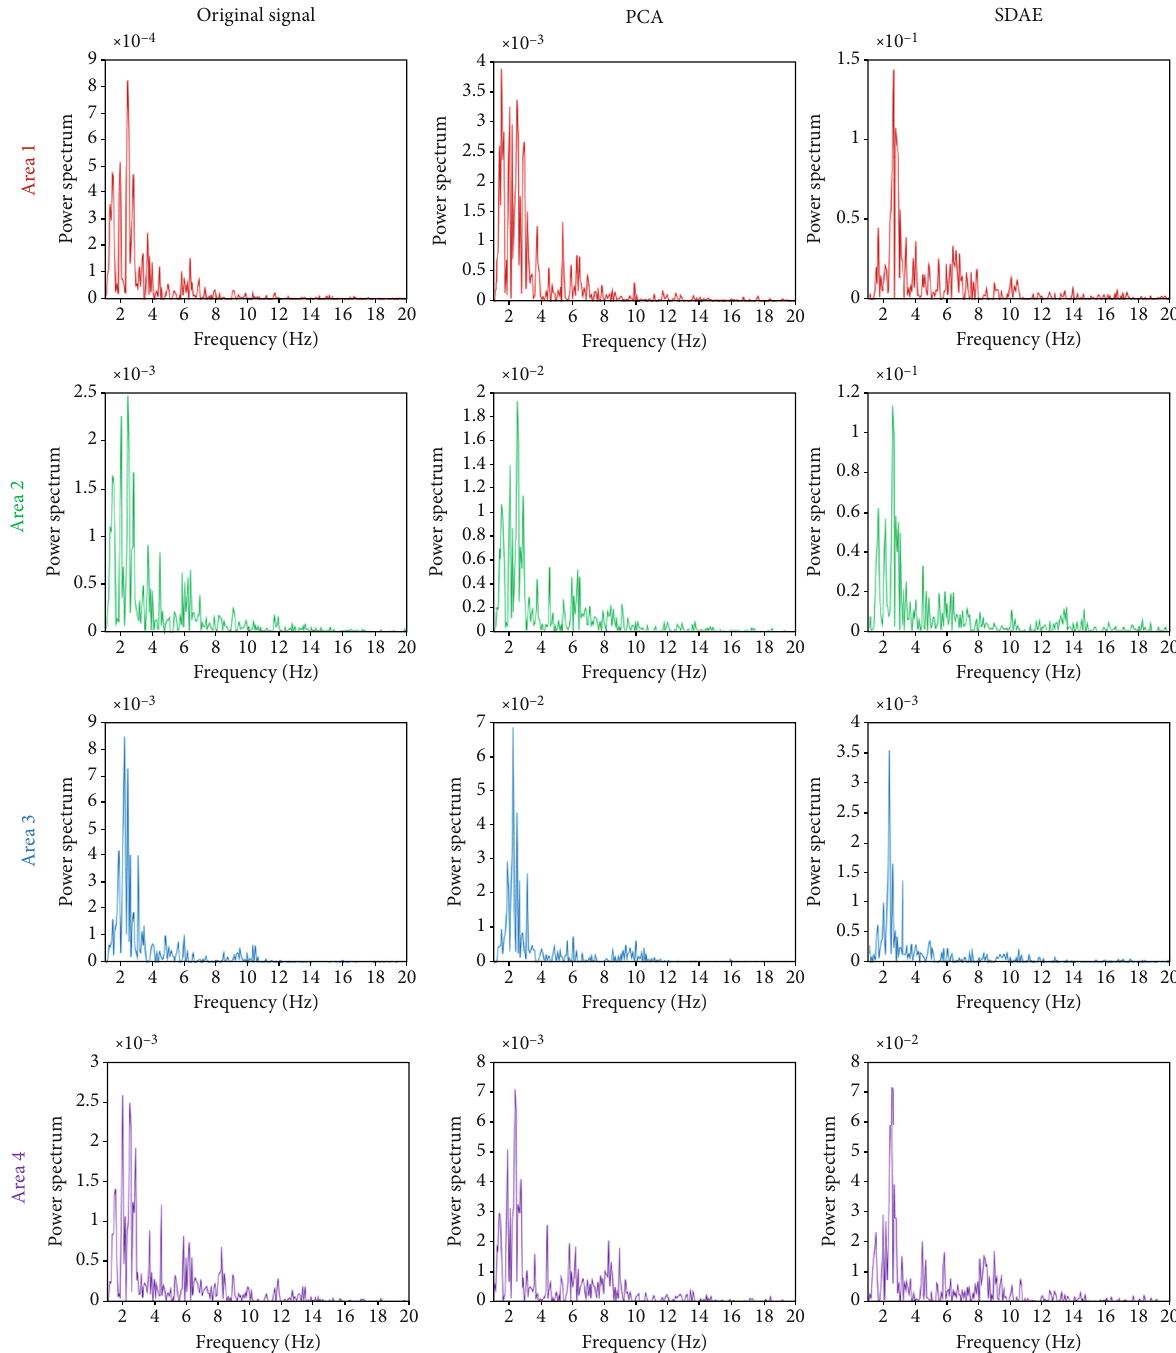
Figure 7: The power spectrum of average original signal, the extracted feature by PCA, and the extracted feature by SDAE from four areas on sleep deprivation